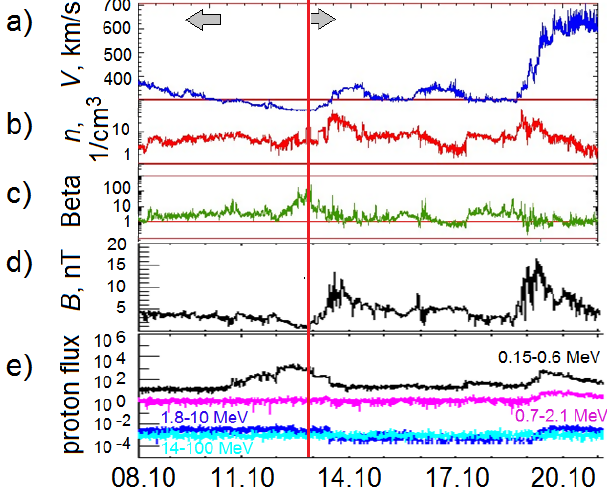
Figure 2. Solar-wind plasma parameters compared with proton flux measured by STEREO-A in different energy channels. (a) The solar-wind speed; (b) plasma density on a logarithmic scale; (c) plasma beta; (d) the IMF strength; (e) and flux of energetic par- ticles (black: 0.15–0.6MeV; purple: 0.7–2.1MeV; dark blue: 1.8– 10MeV; and light blue: 14–100MeV).